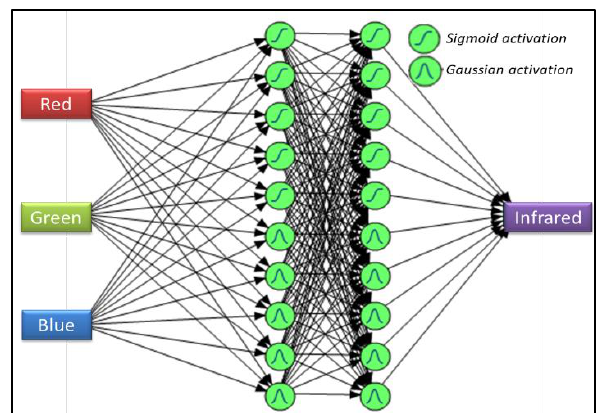
Figure 6 . Neural network diagram of the best model: TanH(5)Gauss(5)-TanH(5)Gauss(5).